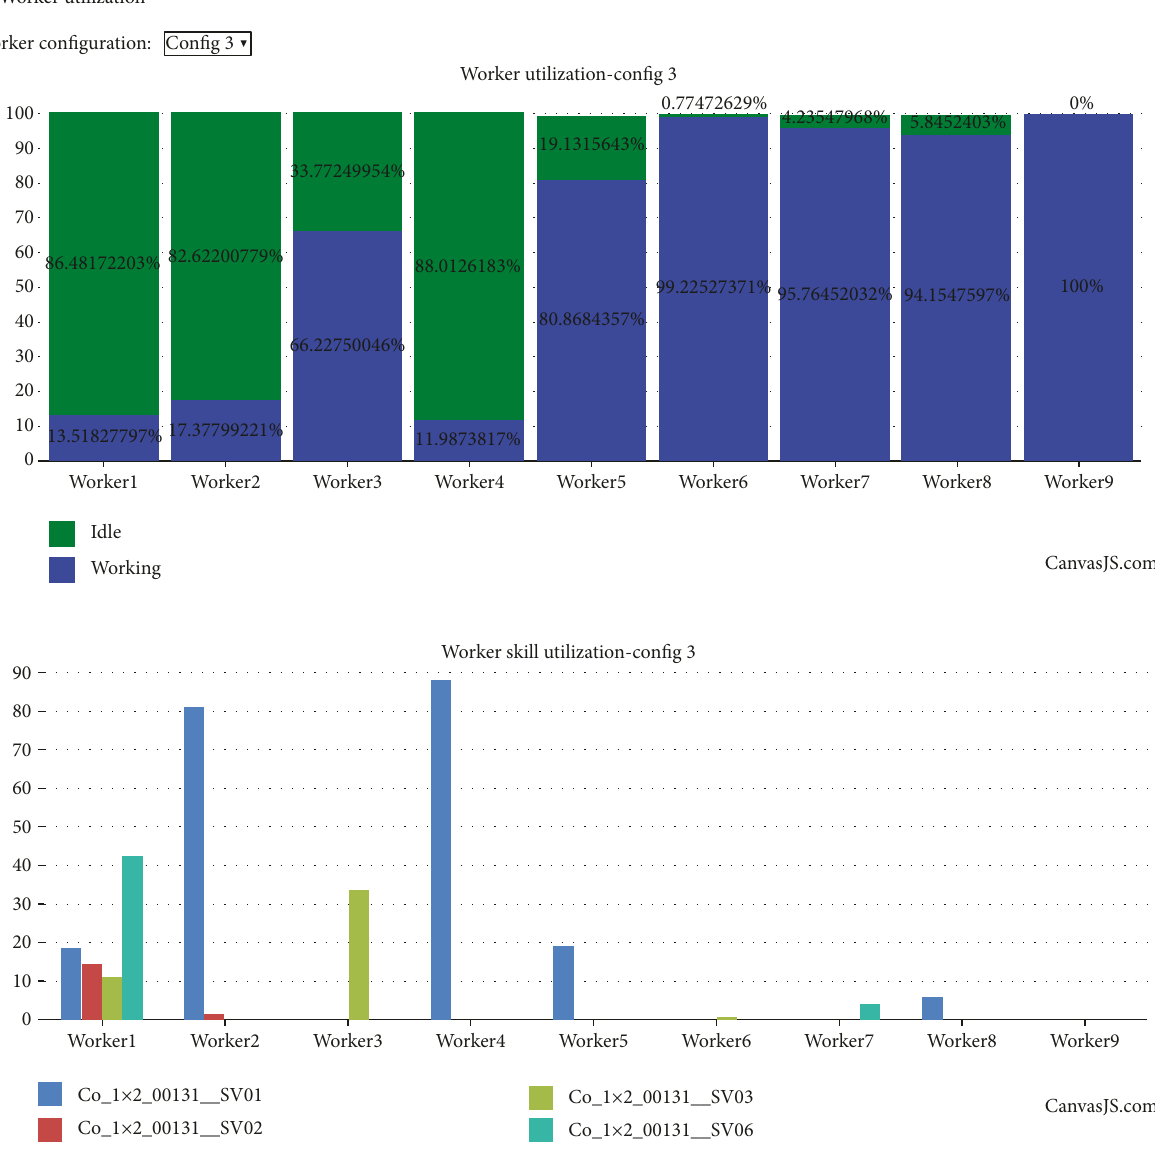
Figure 10: Chart representing the utilization of workers in a con fi